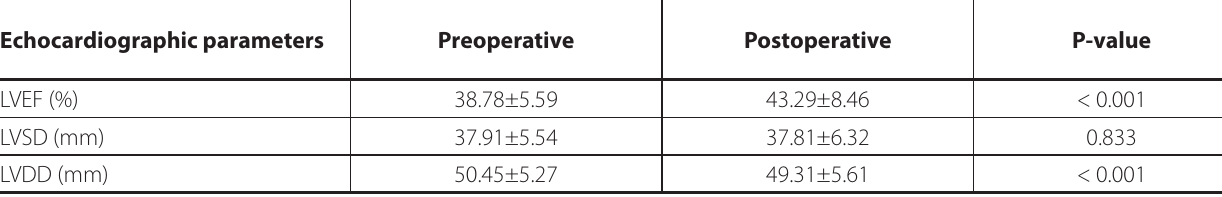
Table 4 . Changes in postoperative echocardiographic parameters for all patients .